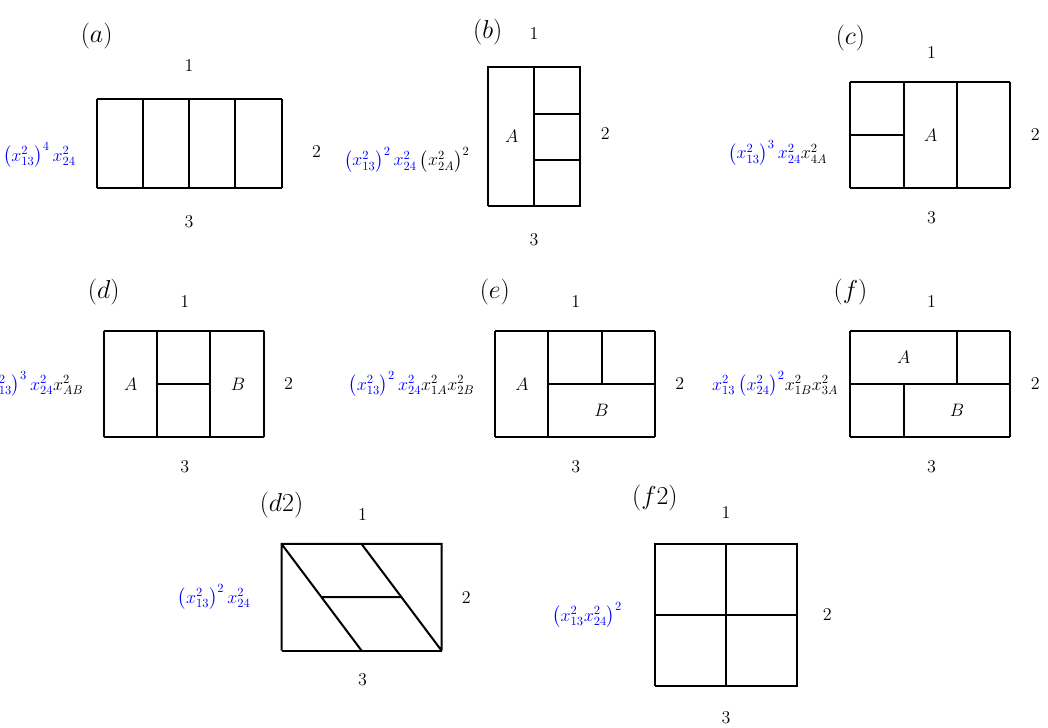
Figure 13 . Four-loop integrals entering eq. (5.33) in scattering amplitude